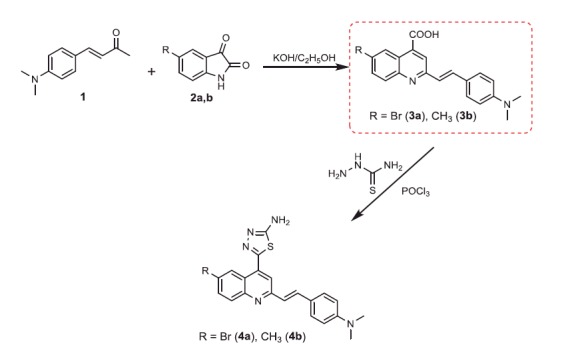
Synthesis of the designed 2-styryl-4-quinoline carboxylic acids, and 1,3,4-thiadiazoles 3a,b and 4a,b.